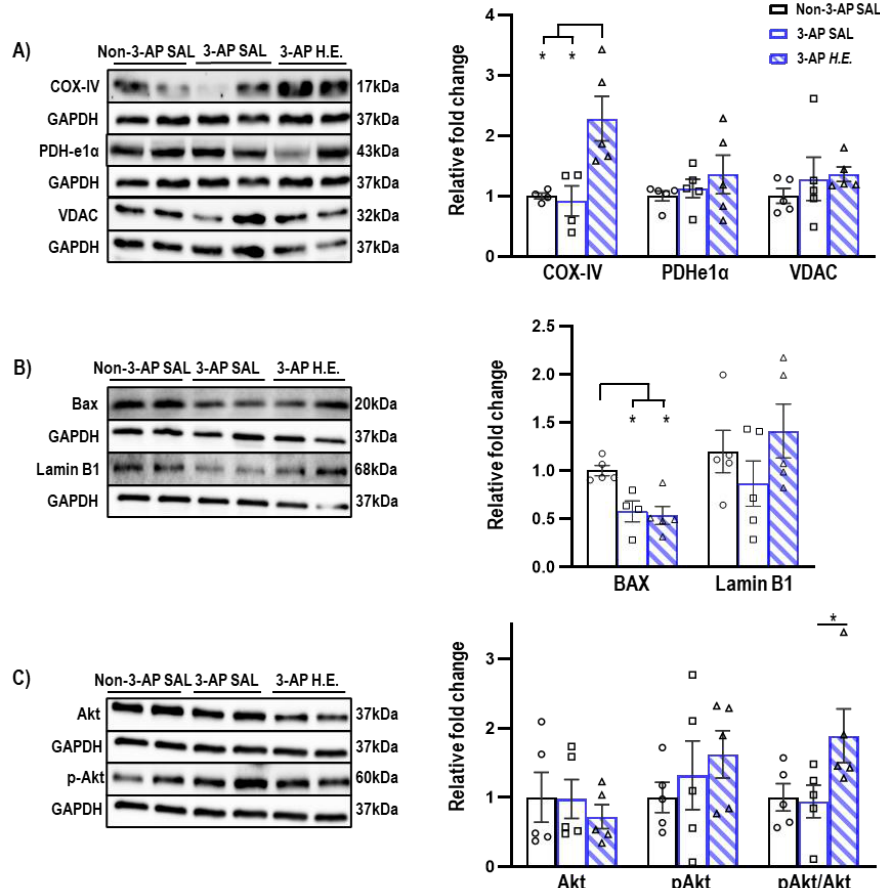
Figure 2. Effects of 3-AP and H.E . treatment on relative protein expressions in the cerebellum. ( A )